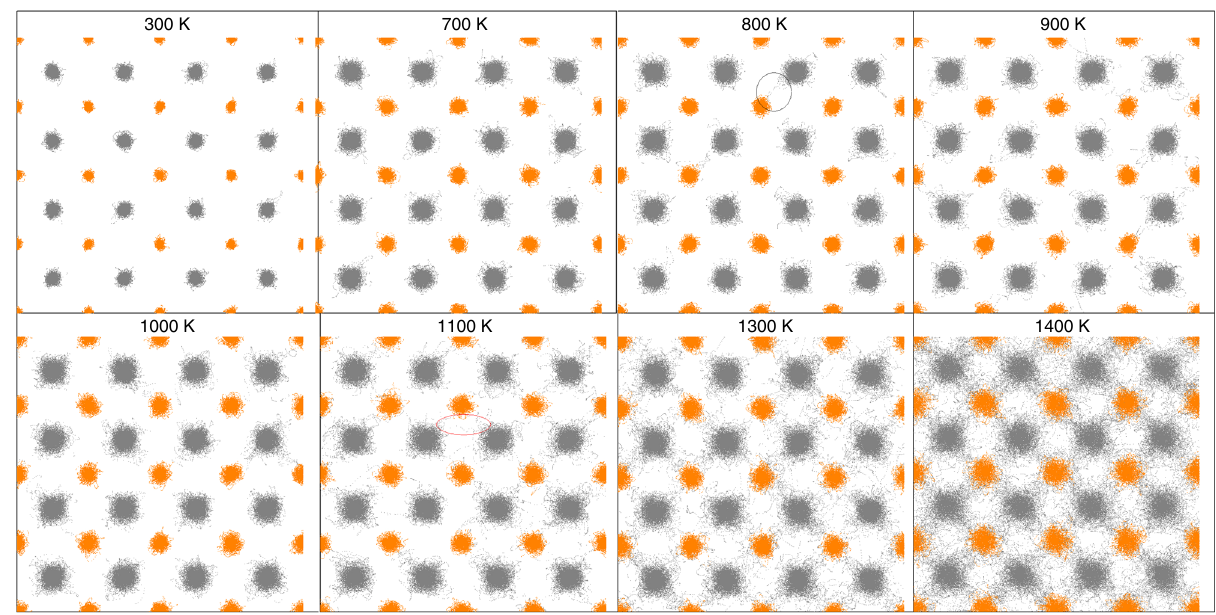
Fig. 3 The trajectory of ions in Li 2 S at different temperatures. Vibration trajectories of Li (gray) and S (orange) ions at various temperatures from ab initio molecular dynamics